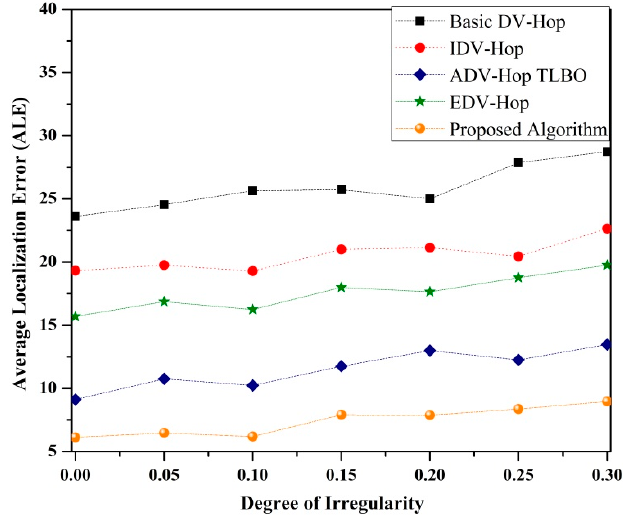
Figure 10. Impact of DOI on ALE.